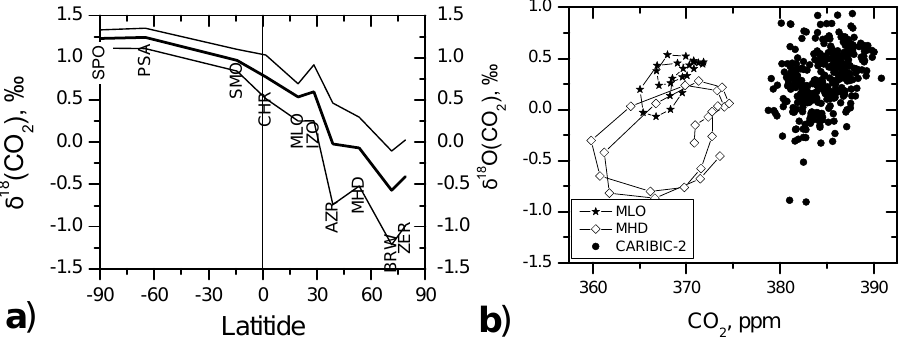
Fig. 13. (a) Global latitudinal gradient of the δ 18 O(CO 2 ) seasonal cycle, data for NOAA stations (White and Vaughn, 2009). Mean values and the amplitudes, averaged for years 2003 to 2005 are shown. (b) The δ 18 O(CO 2 ) seasonal cycle at Mauna Loa and Mace Head, years 1999–2000. The cycle direction is anti-clock wise. CARIBIC-2 data: tropospheric air, latitudes > 14 ◦